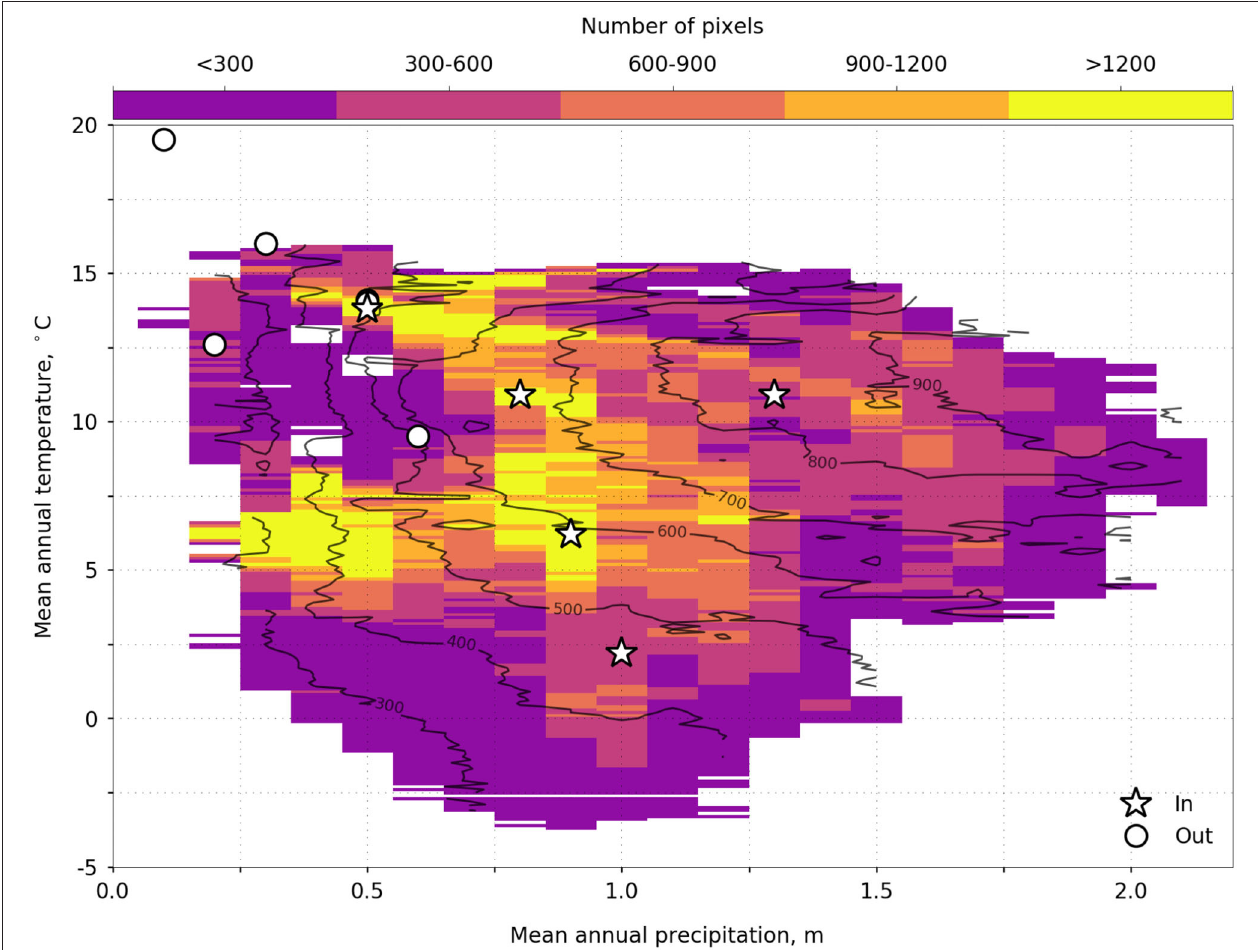
FIGURE 7 | Flux tower representativeness of precipitation, temperature, and predicted evapotranspiration. Stars are flux towers within the boundary of the study area, and the circles are the remaining flux towers in